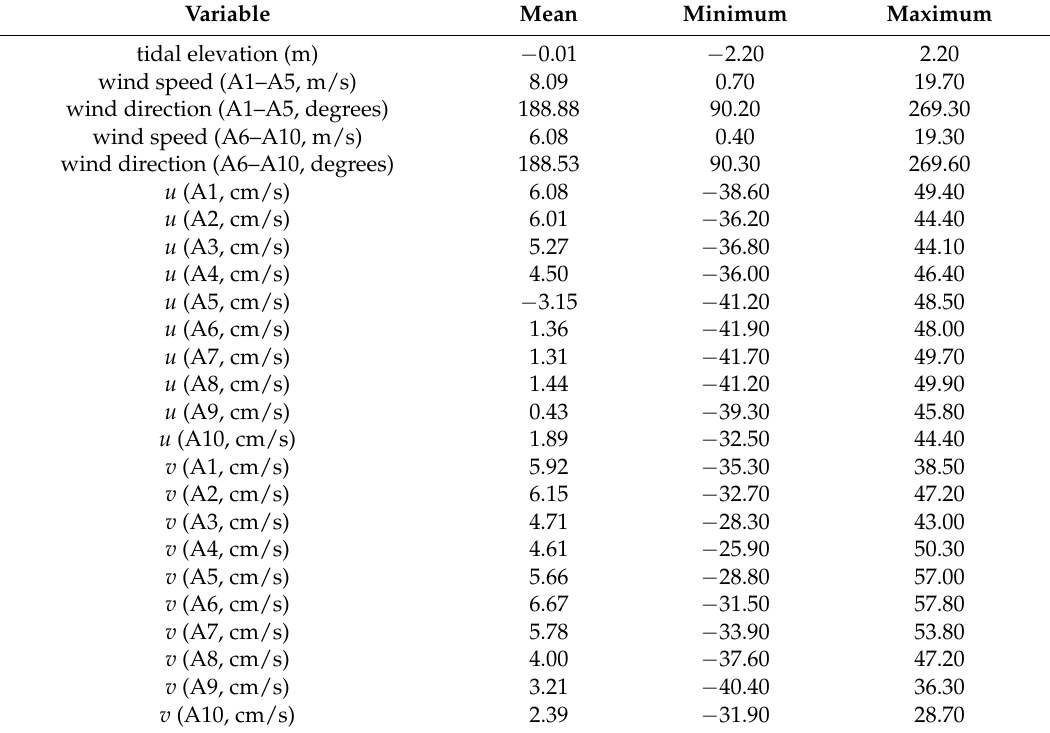
Table 3. Mean and range of forecasting dataset (20% of full